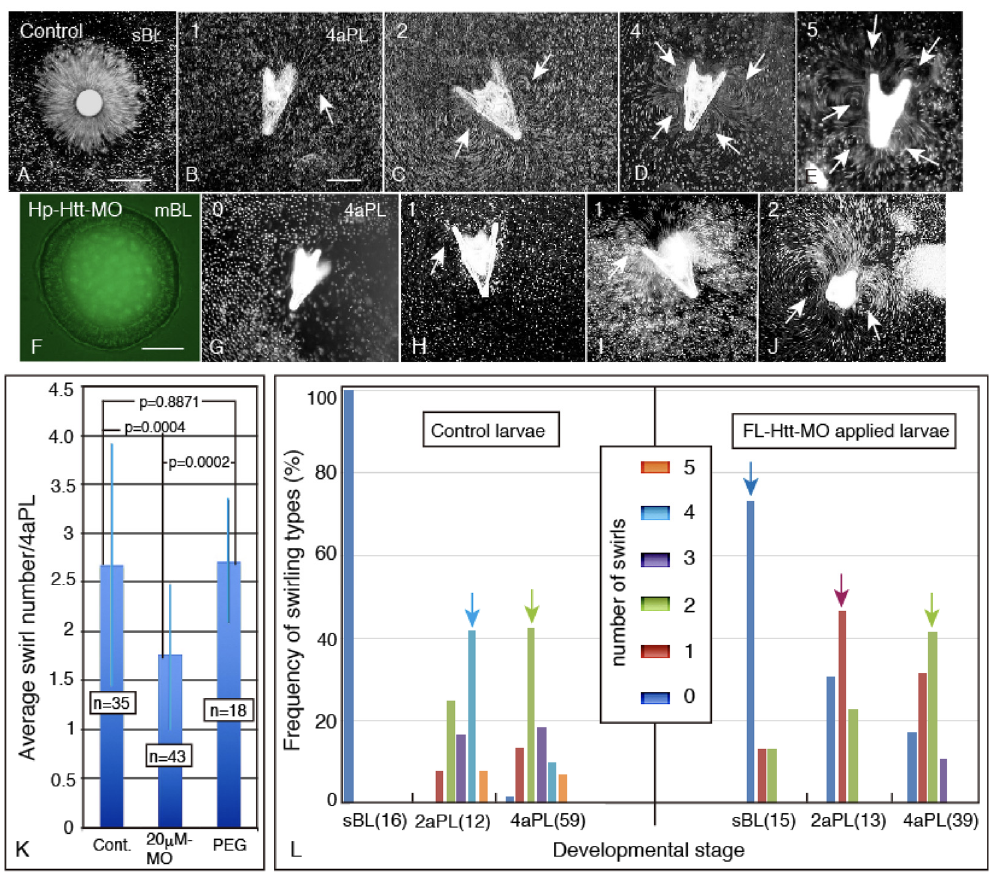
Figure 6. Increasing number and types of swirling patterns (arrows) during development. ( A ) A water current around the body surface with no swirling pattern of the control sBL. ( B – E ) Control 4aPLs with different numbers of swirling patterns. The number on the upper left corner is that of swirls. ( F ) Fluorescence microscopy of FL-Htt-MO in the blastocoel of mBL before fixation. ( G ) An FL-Htt-MO -treated 4aPL generated no water current around the body. ( H – J ) The swirling patterns of FL-Htt-MO -treated 4aPL. The upper left number shows that of swirls. The arrows point to the swirls. ( K ) The average number of swirlings of 4aPL of control (Cont), FL-Htt-MO (20 µM MO)-treated, and Endo-Porter PEG (PEG) alone. The numbers in boxes on each blue column indicate those of the samples. Thinner blue vertical bars on the top of each column show the standard deviations. p values are shown between two subjected columns connected with lines. ( L ) Frequency of the swirling pattern types, from sBL to 4aPL, are shown in the central box, with dark blue for zero swirls to five swirls in the orange column. The control larvae are on the left side and the FL-Htt-MO -treated larvae on the right side of the graph. The numbers in parentheses at the end of the developmental stage names show that of samples that were examined in that stage. The light blue arrow in the control group points to the major swirling pattern group in the control 2aPL. The green arrow shows the major swirling pattern group in the control 4aPL. The dark blue arrow at the top of the dark blue column of the FL-Htt-MO -treated groups shows the major swirling type of the sBL. The brown arrow at the top of the brown column shows the major swirling type of the 2aPL. The light green arrow at the top of the green column in the FL-Htt-MO -treated groups shows the major swirling type of the 4aPL. Scale bars = 100 µm ( A ), 50 µm ( B ), 30 µm ( F ).